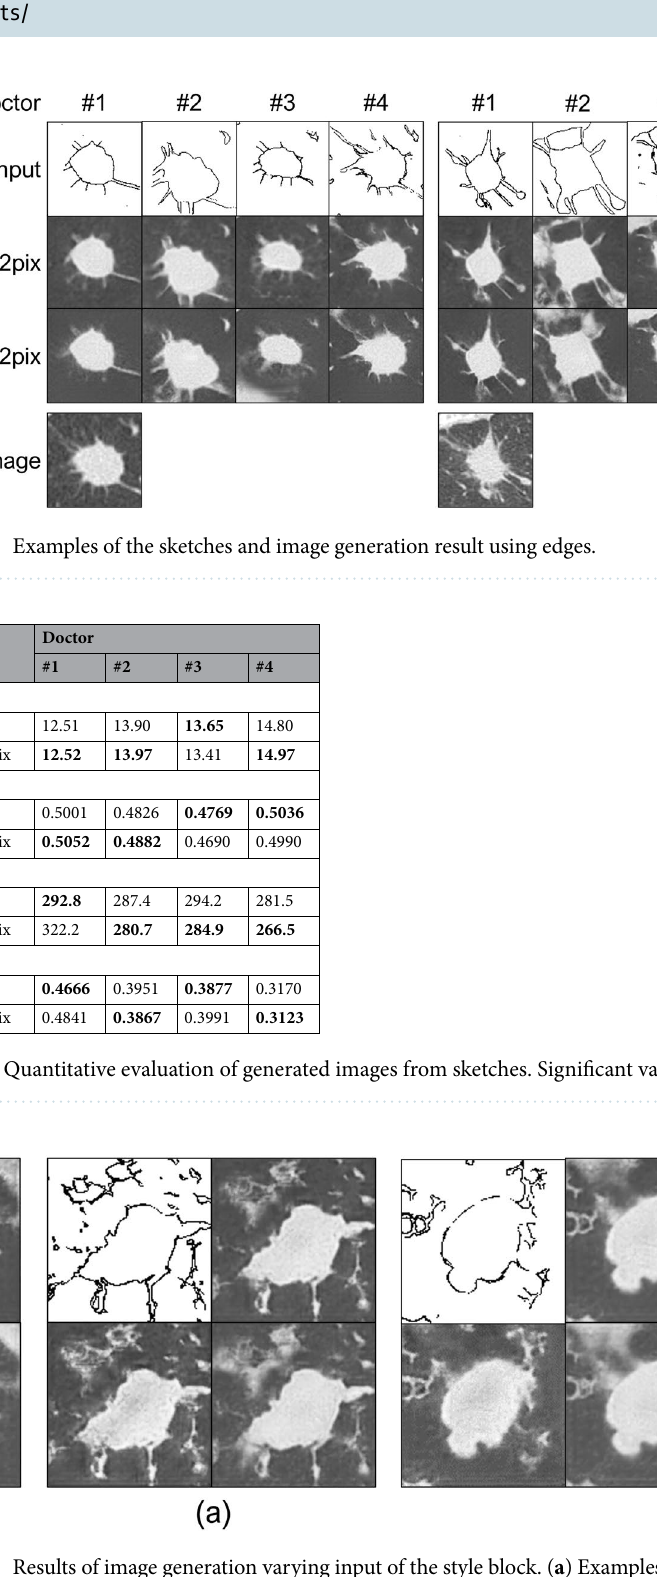
Figure 7. Results of image generation varying input of the style block. ( a ) Examples of generated images. ( b ) Comparison of lung substances in the dataset (upper: healthy, lower: